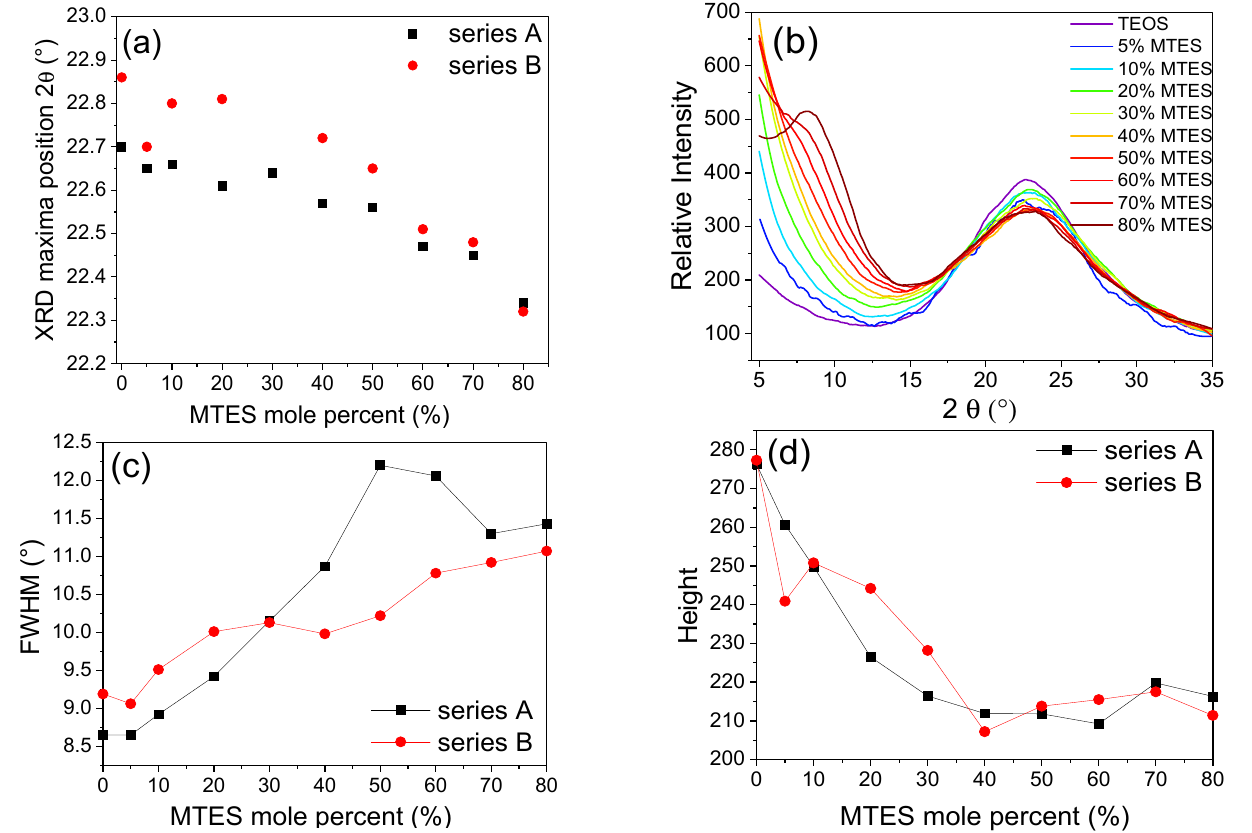
Figure 8. ( a ) XRD maxima position shift, ( b ) plots of the relative intensities as a function of MTES substitution, ( c ) FWHM and ( d ) peak height changes with MTES content for series A and B, respectively (series A and series B labels represent the pH = 2.0 and pH = 4.5).